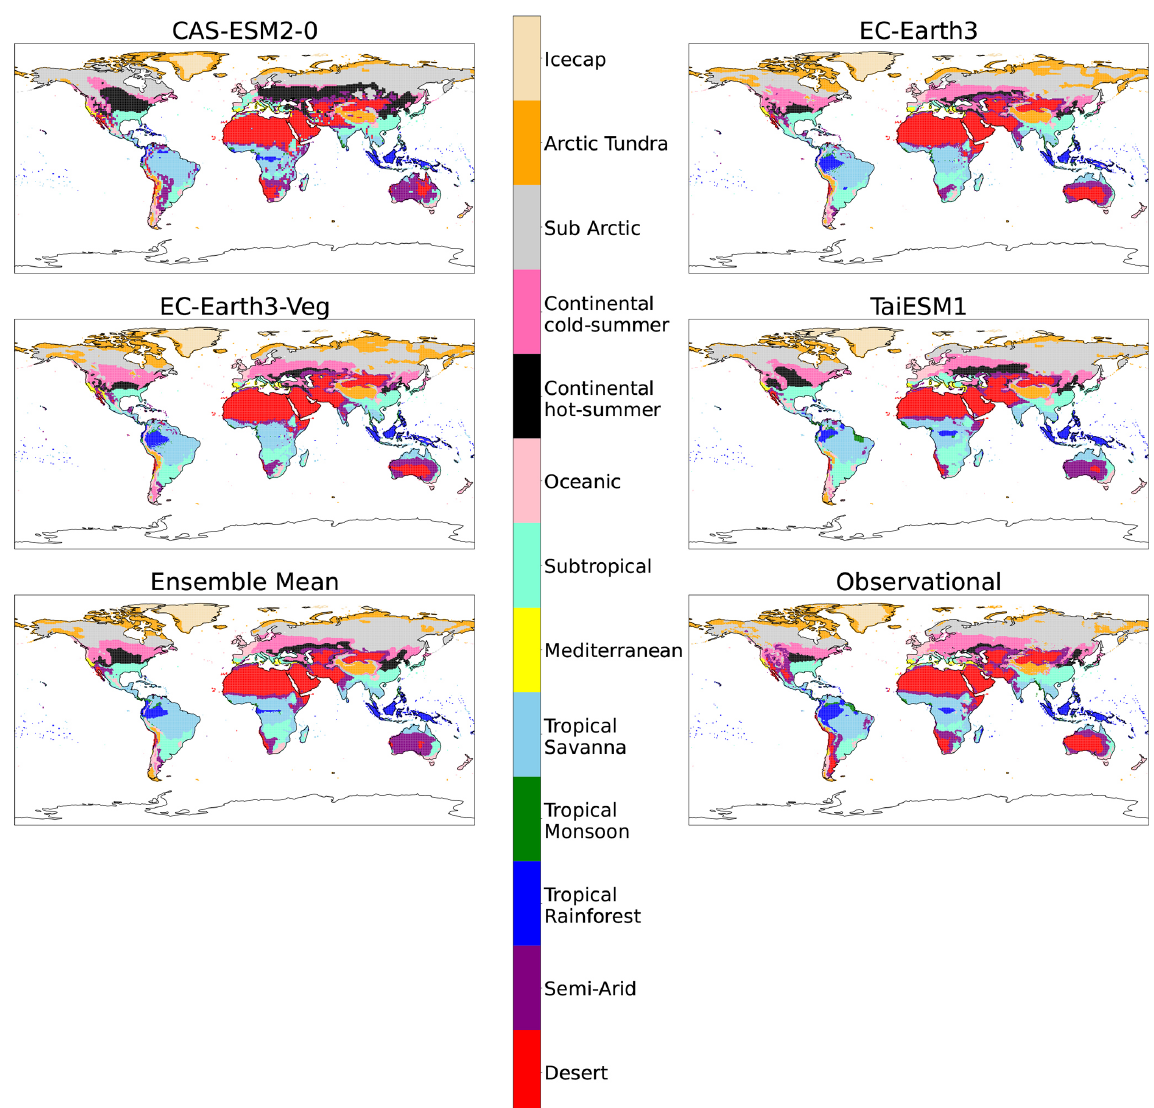
Figure B1. Maps of streamlined KG classifications for each model for the reference period (1901–1931) without anomaly